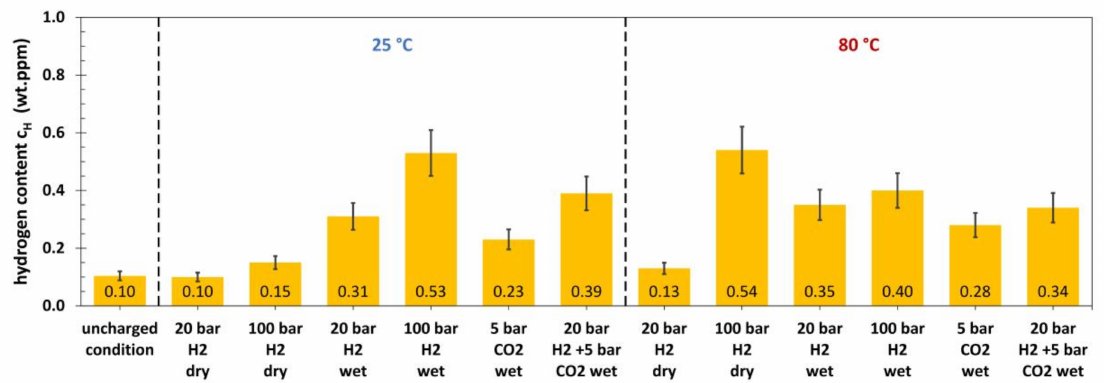
Figure 5. Hydrogen content of 42CrMo4 after 30 days of autoclave testing with various media at 25 ◦ C and 80 ◦ C (wet conditions: with electrolyte; 15,000 ppm Cl −